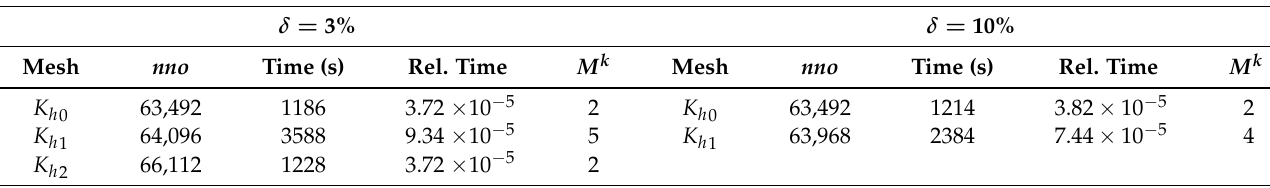
Table 6. Test 2. Performance of the reconstruction Algorithm 4 (in seconds) on adaptively refined meshes. Here, k is the number of the refined mesh K hk of the domain Ω FEM , nno is the number of nodes in the computational mesh K hk , and M k denotes the final number of iterations in the conjugate gradient Algorithm